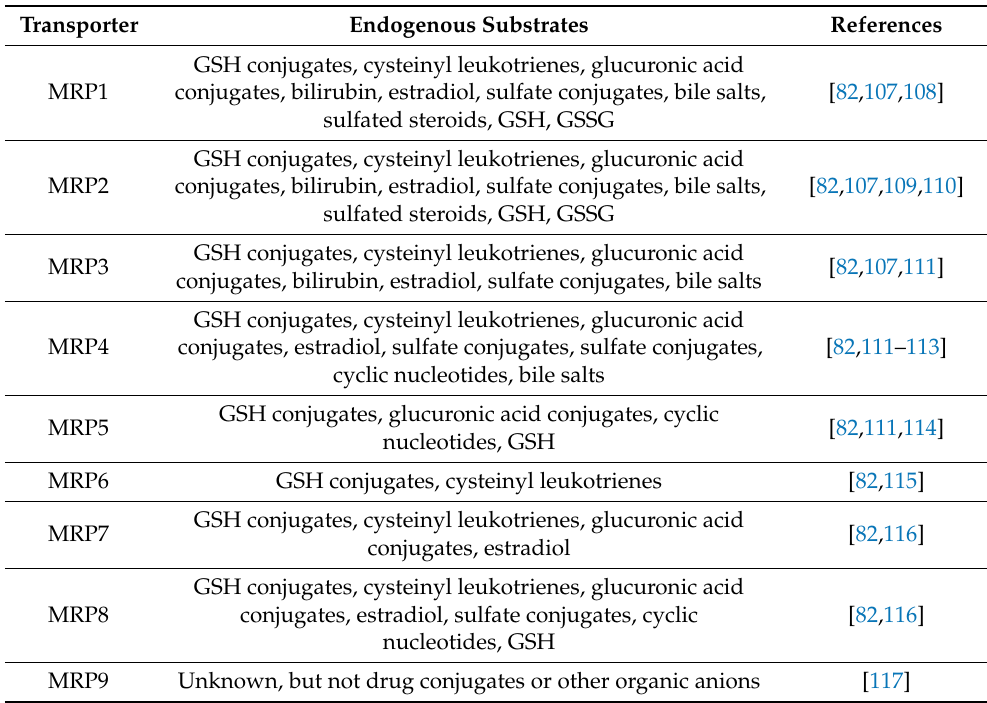
Table 2. Family of MRP transporters and the molecules they transport.